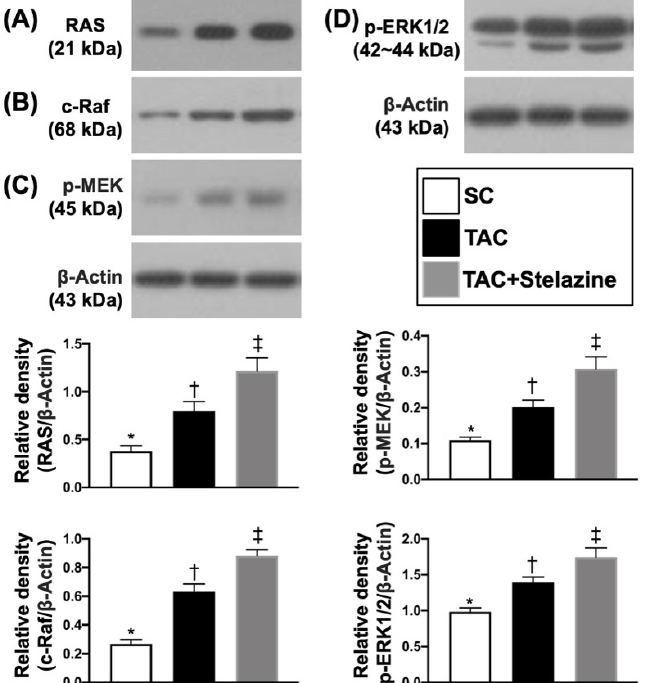
Figure 6. Protein expressions of EGF signalings by day 28 after TAC procedure. ( A ) Protein expression of RAS, * vs. other groups with different symbols (†, ‡), p < 0.0001. ( B ) Protein expression of c-RAF, * vs. other groups with different symbols (†, ‡), p < 0.0001. ( C ) Protein expression of p-MEK, * vs. other groups with different symbols (†, ‡), p < 0.0001. ( D ) Protein expression of p-ERK1/2, * vs. other groups with different symbols (†, ‡), p < 0.0001. All statistical analyses were performed by one-way ANOVA, followed by Bonferroni multiple comparison post-hoc test (n = 6 for each group). Symbols (*, †, ‡) indicate significance (at 0.05 level). SC = sham-operated control TAC = transverse aortic constriction; Ras = rat sarcoma; ERK = extracellular signal-regulated protein kinase; MEK = mitogen-activated protein kinase kinase; Raf = proto-oncogene c-RAF.